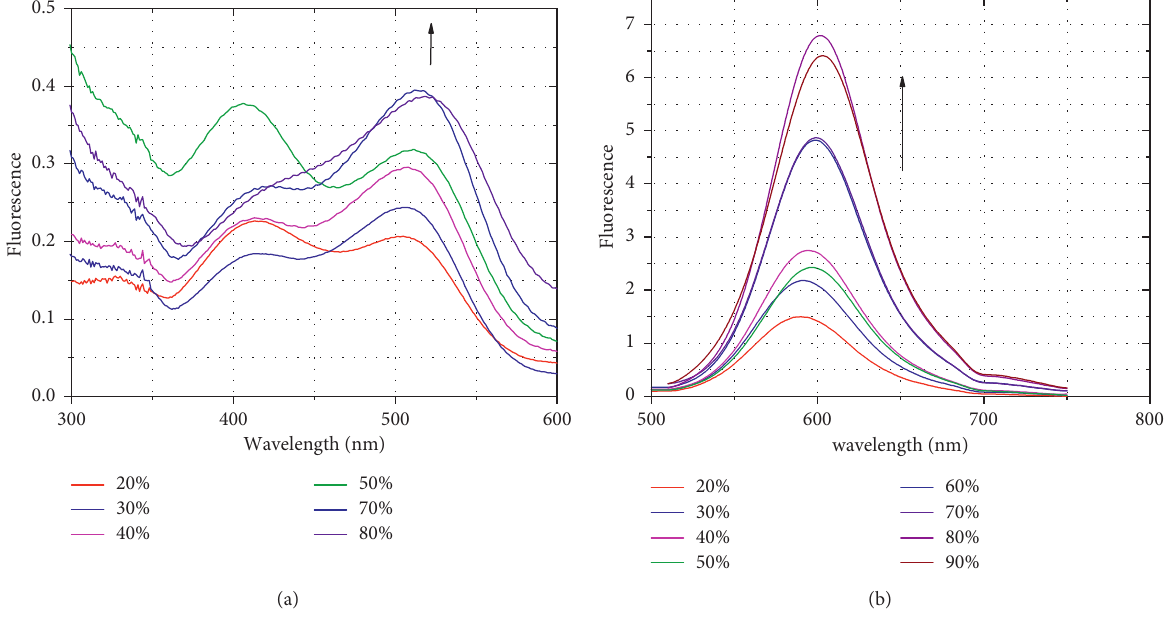
Figure 14: Fluorescence spectra ( λ � 500nm) of coumarin 3 (1 × 10 − 5 M) in 10% ethanolic aqueous solutions (a) and its fluorescence ex intensity (b) with increasing sodium dodecyl sulfate (SDS) concentrations.